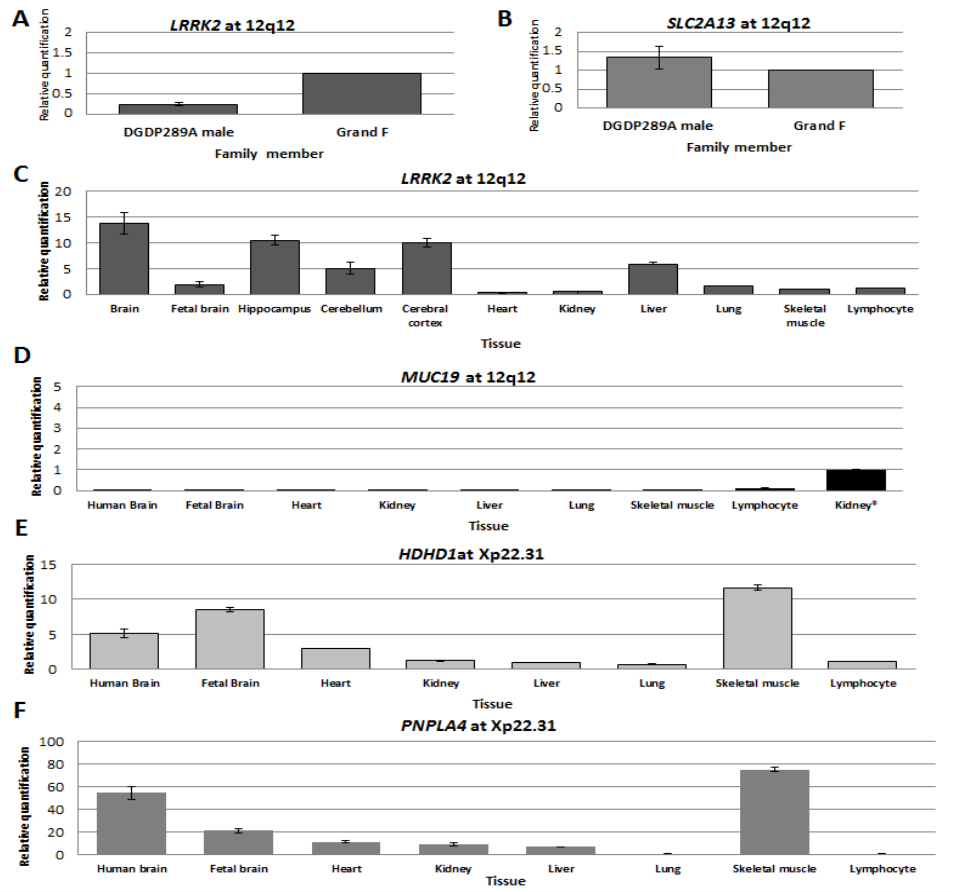
Figure 4. Transcript levels of genes at 12q12 and Xp22.31. Expression levels of LRRK2 ( A ) and SLC2A13 ( B ) in LCLs established from patient DGDP289A and his paternal grandfather. ( C – F